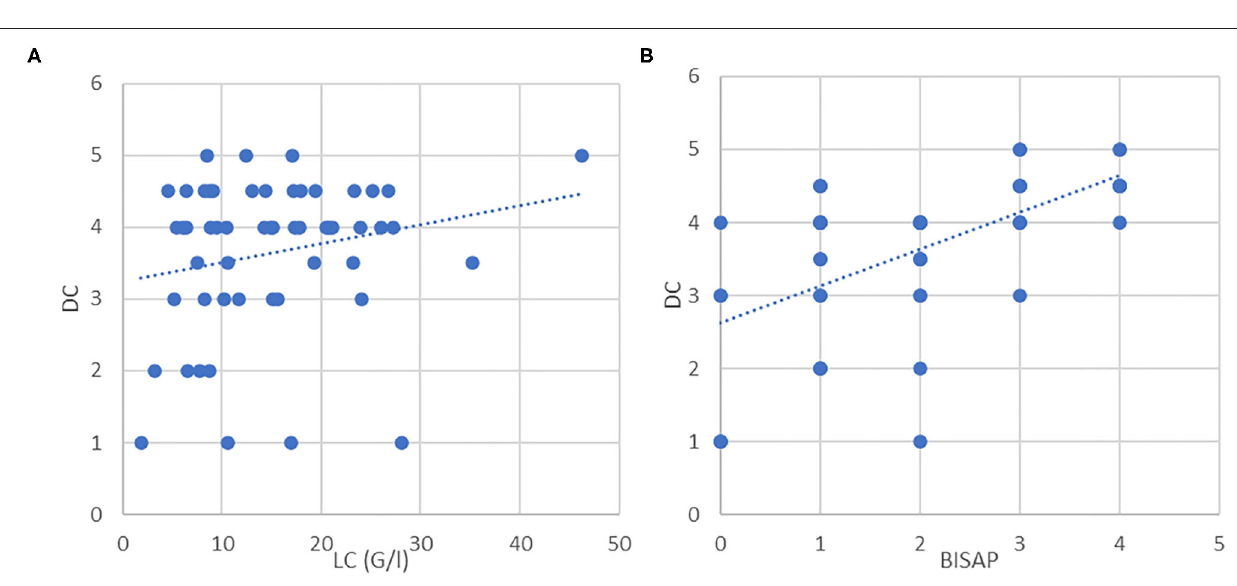
FIGURE 2 | (A) Correlation between LC and DC ( P = 0.122). (B) Correlation between BISAP and DC ( P <